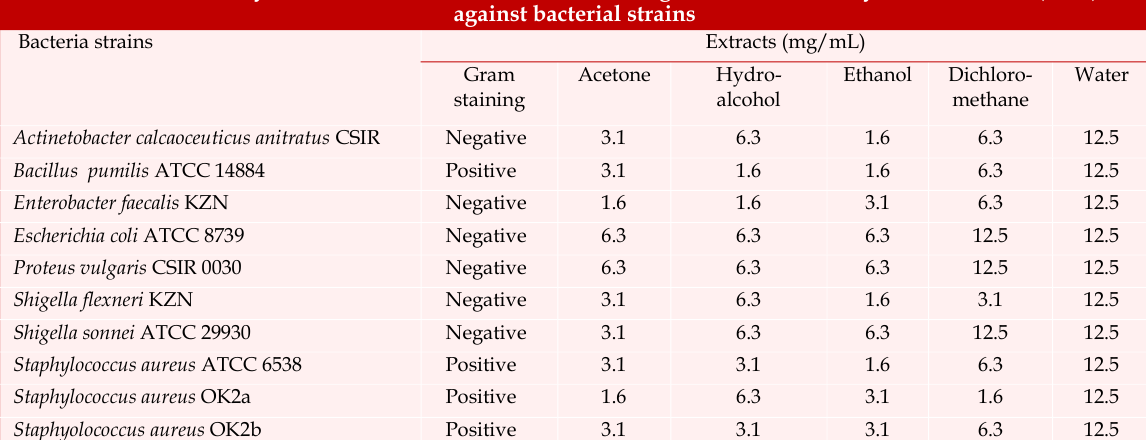
Antibacterial activity of Dianthus basuticus extracts showing minimal inhibitory concentrations